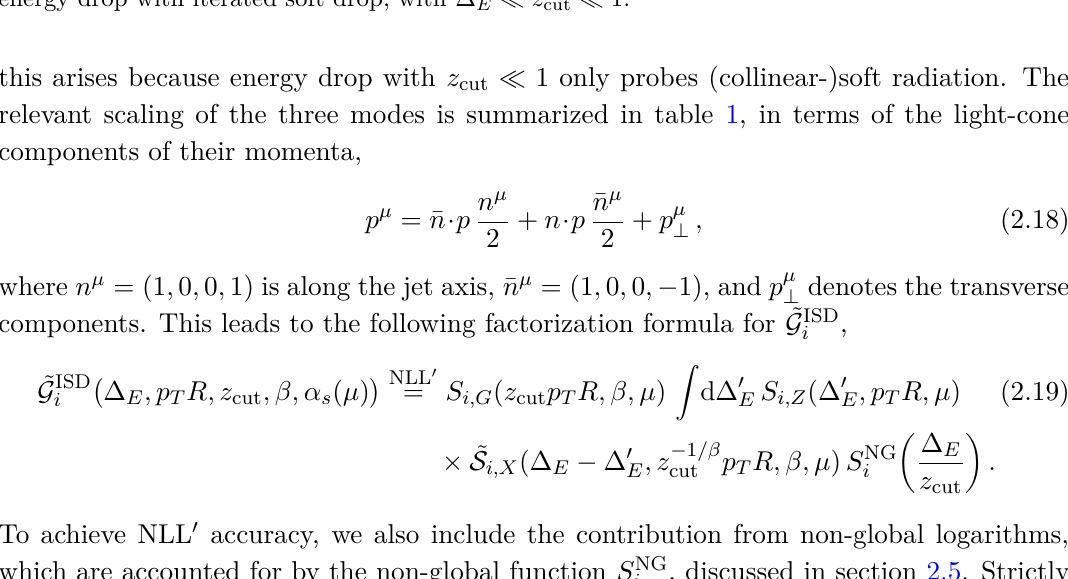
Table 1 . The modes in SCET that enter in the refactorization of the jet function ˜ G ISD energy drop with iterated soft drop, with ∆ E (cid:28) z cut (cid:28) 1